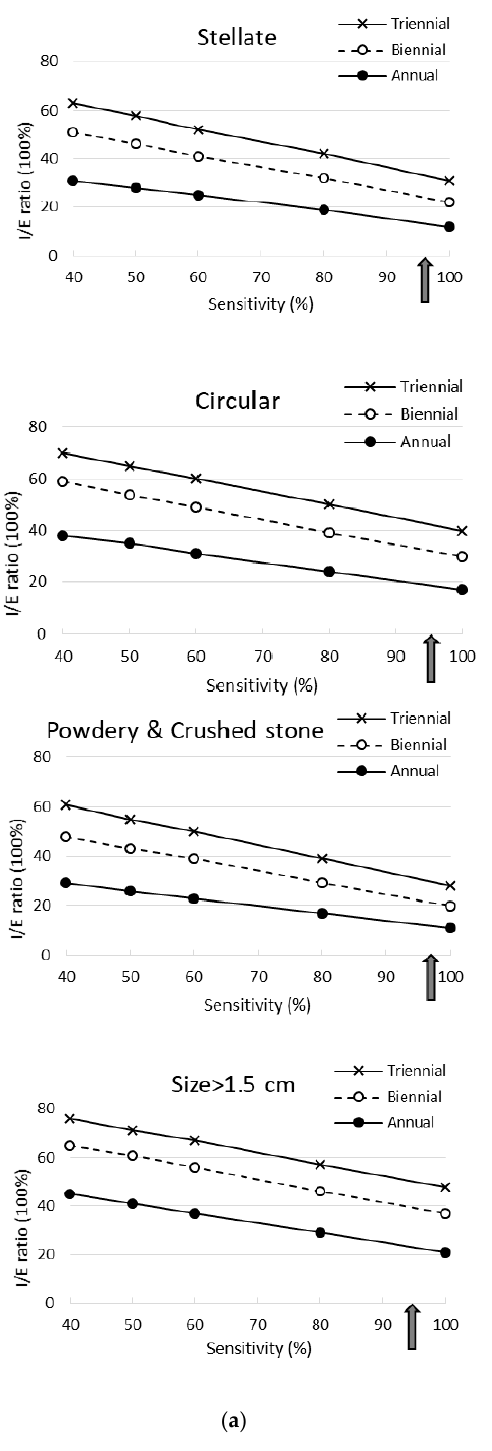
( b ) Figure 3. Cumulative risk from PCDP to CP without early detection for three types of mammographic appearance with tumor size <15 mm and ≥ 15 mm among AAB breast tumor in the two periods. ( a )1977–1985; ( b )1996–2010. 2.2. Empirical Estimates of I/E Ratio by Mammographic Features Using the parameters estimated from Figure 2 in the second period (1996–2010), Figure 3a (see